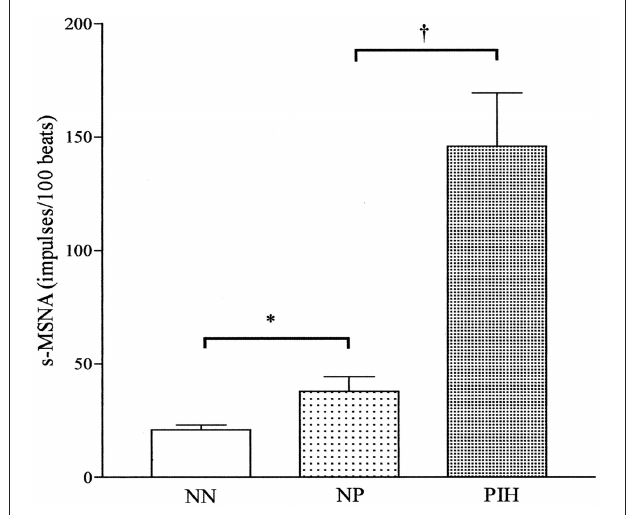
FIGURE 3 | Resting mean frequency of single-unit muscle sympathetic nerve activity (s-MSNA) in the three groups of subjects, NN, NP, and PIH, expressed as mean (height of columns) and S.E.M. (bars). NN, normotensive non-pregnancy; NP, normotensive pregnancy; PIH, pregnancy-inducedhypertension. ∗ P < 0 . 05; † P < 0 . 001. Adapted with permission from Greenwood et al.